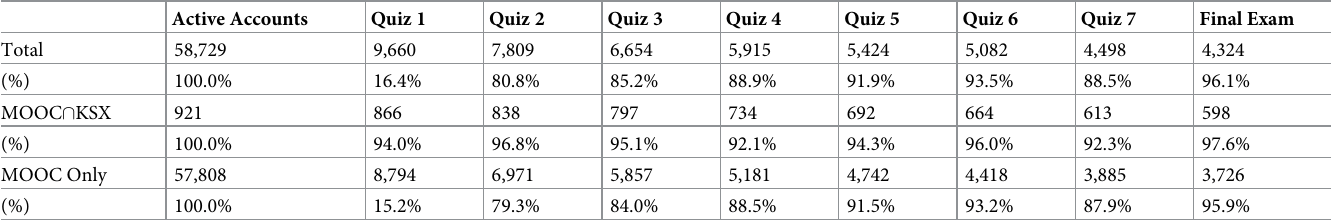
Table 4. Completion rates by progress stage (based on completing the previous